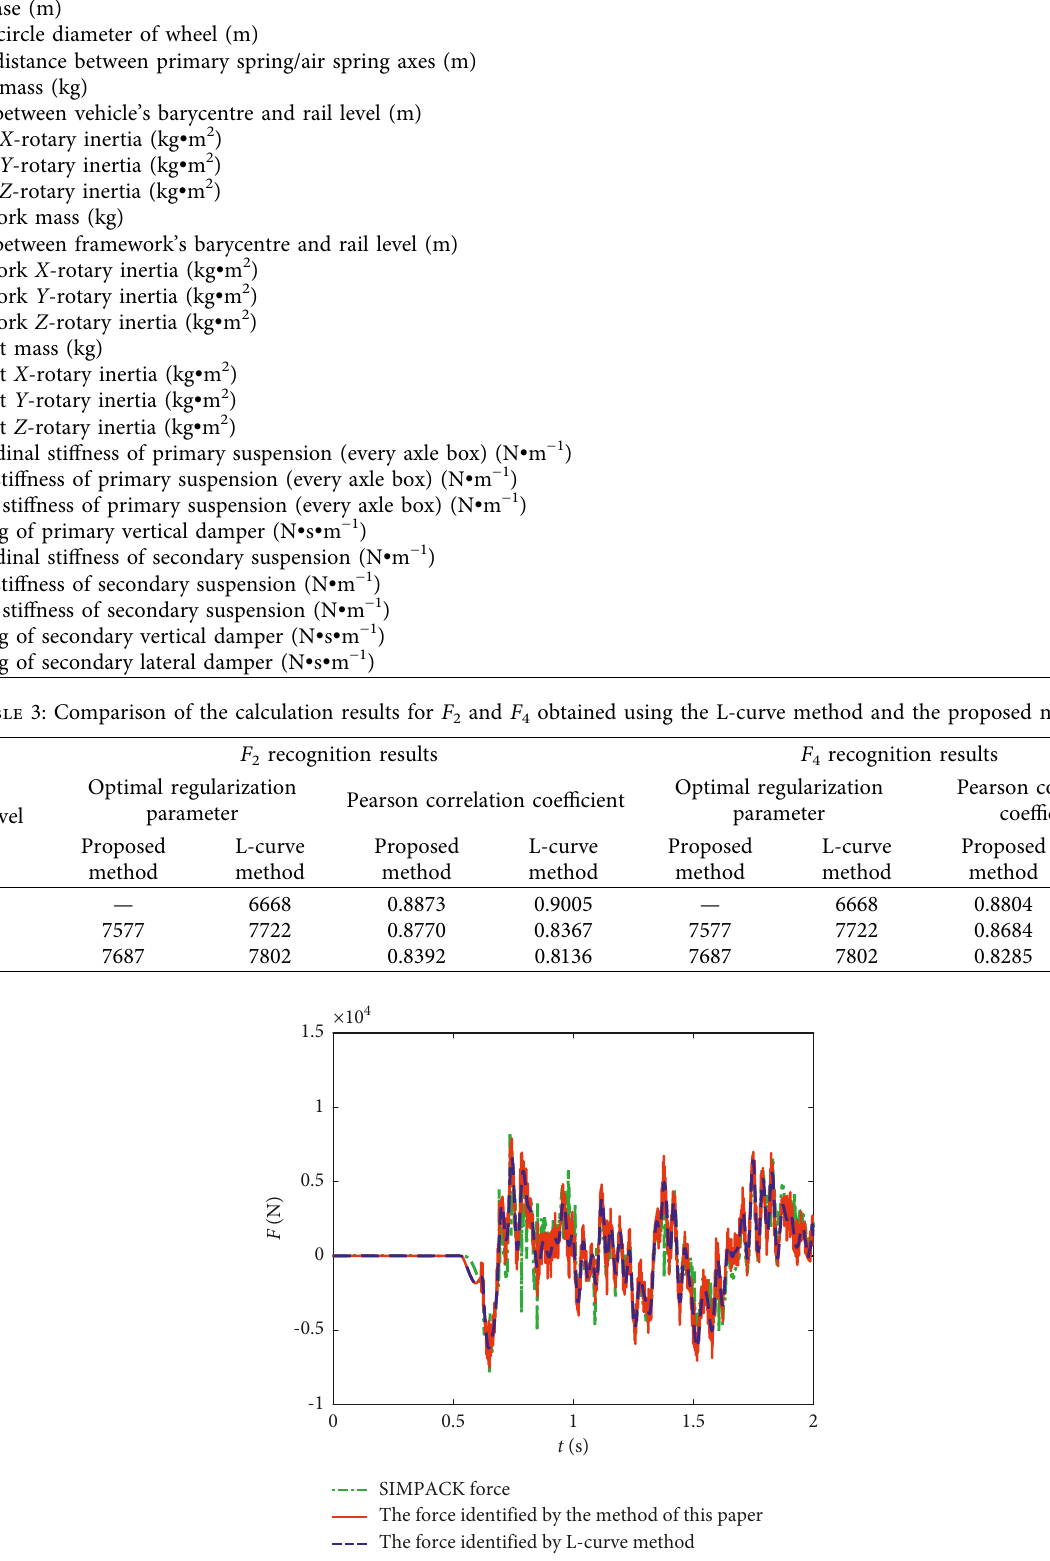
Figure 5: Load time-history diagram of the two methods for F